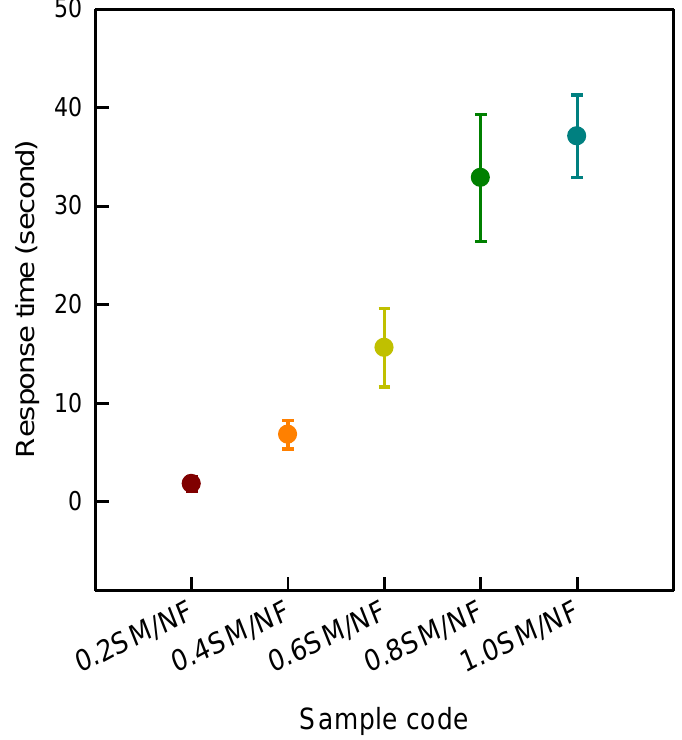
Figure 6. Di ff erences of response time on thickness of 3D-printed sinusoidal sample / nylon composite Figure 6. Differences of response time on thickness of 3D-printed sinusoidal sample/nylon composite with various with various thicknesses.